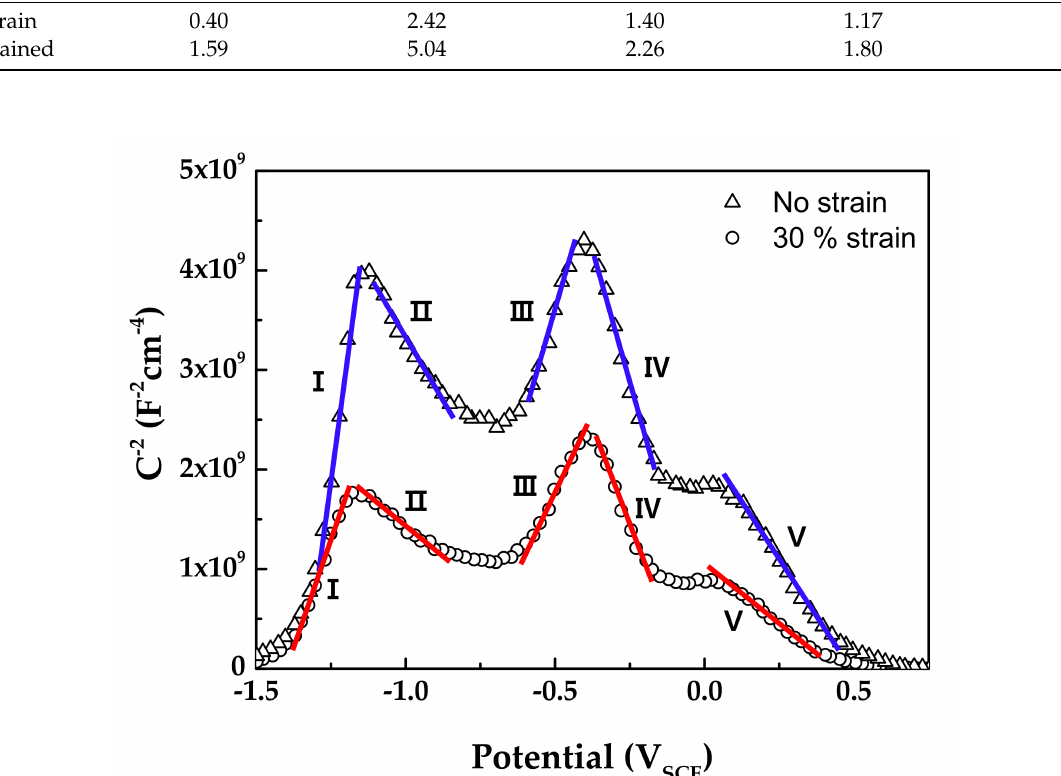
Figure 10. Mott–Schottky plots of oxide films formed on Alloy 600 specimens in simulated PWR secondary water at 340 ◦